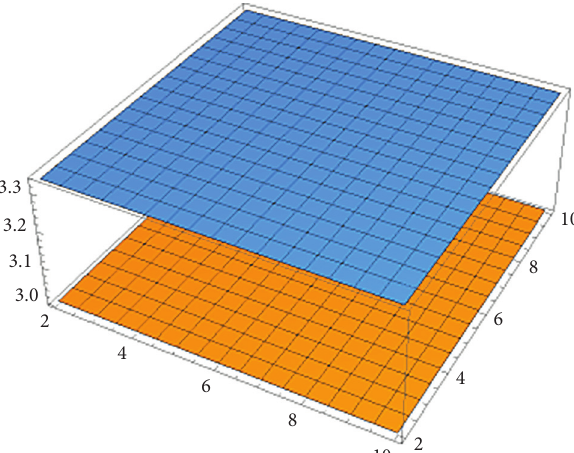
Figure 8: Dominance of the right-hand side of equation (37) is visually checked for τ , υ >